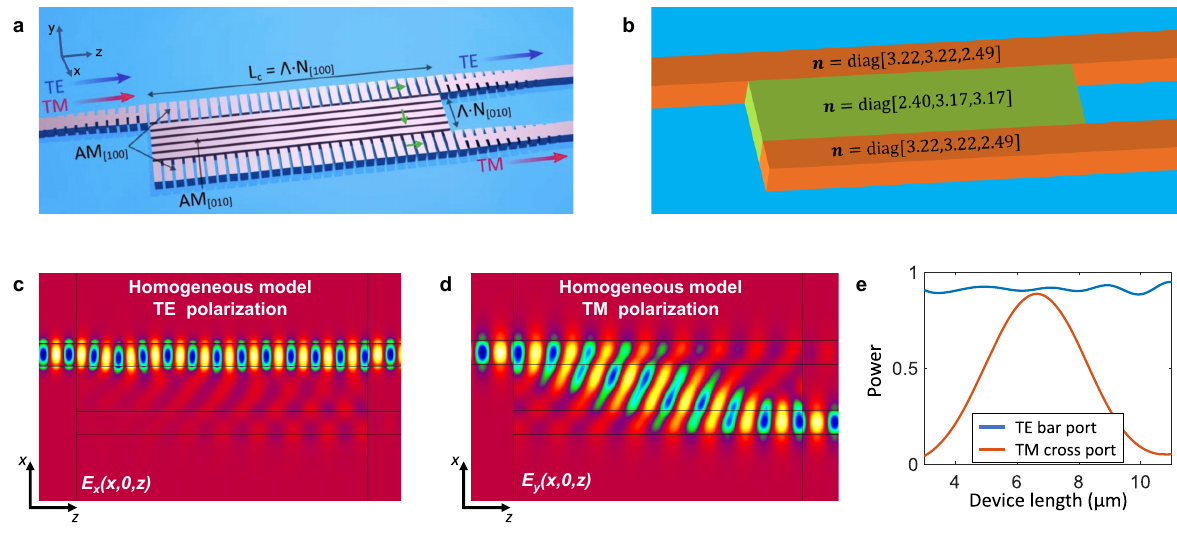
Figure 21: (a) A polarization splitter based on a dual subwavelength structure (reproduced with permission from Ref. [31]). (b) Using the anisotropic material models developed in Section 2, a much simpler, equivalent device can be constructed. (c, d) Electric fi eld propagation obtained via modal simulation for TE and TM polarization through the equivalent device. (e) Power in the fundamental modes of the cross and bar ports as function of device